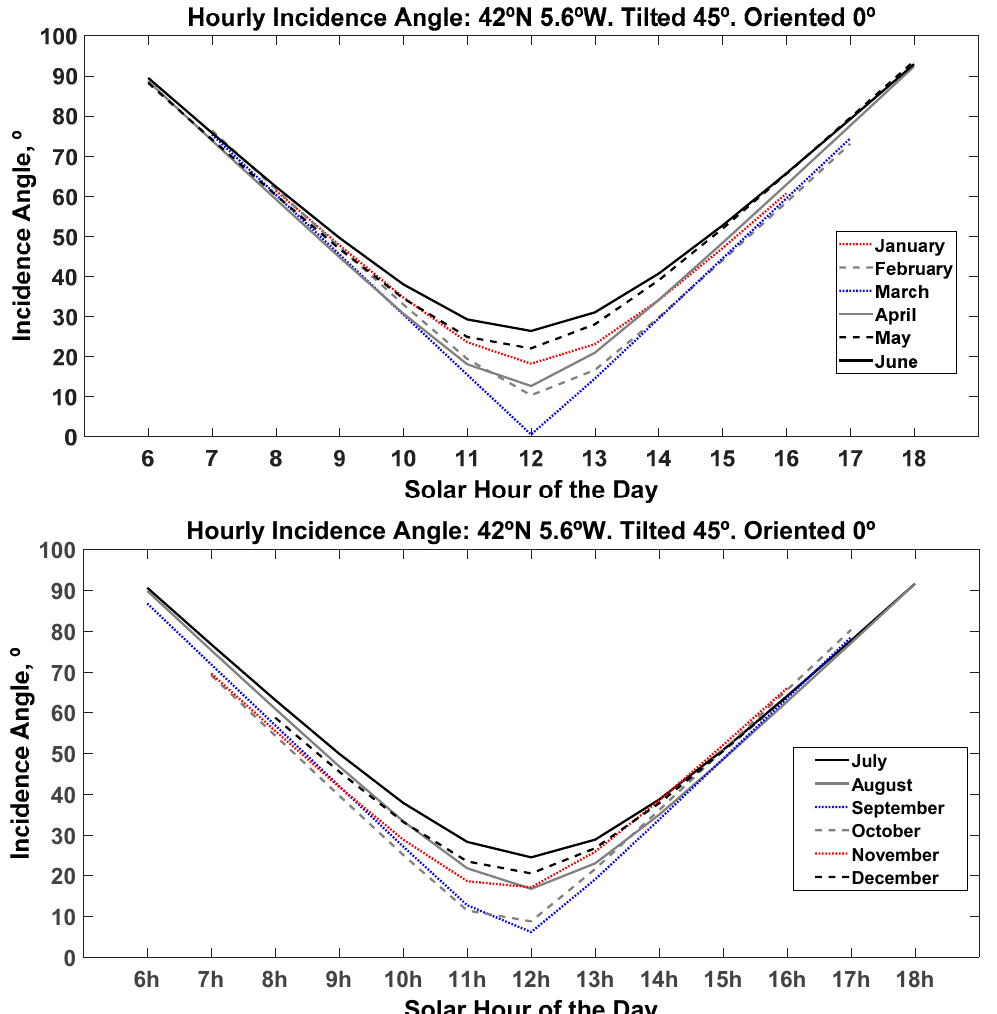
Figure 7. Hourly incidence angle calculated at latitude 42° N and longitude 5.6° W for the 15th day of each month. ( Top ) January to June; ( bottom ) July to December. The minimum values of the angle of incidence, which were obtained at solar noon for each day of the year, are presented in Figure 8. Incidence Angle at Solar Noon: 42ºN 5.6ºW. Tilted 45º. Oriented 0º Figure 8. Incidence angle at solar noon calculated at latitude 42° N and longitude 5.6° W for all days of the year. 3.5. Results for Hourly Global Irradiance and Hourly Mean Solar Irradiance on the Solar Panel The data recorded for the global solar irradiation on the horizontal surface during 2011 in the agrometeorological station located in the town of Mansilla Mayor (León, Cas- tile and León region, Spain), as part of the SIAR network, were used to apply the method- ology developed in Simulink-MATLAB for the estimation of the global solar irradiation value on a surface with an inclination of 45° and oriented towards the equator. The results of the different methods of obtaining diffuse solar irradiation are shown below. Figure 9 shows the values of the daily global solar irradiation obtained from the hor- izontal SIAR network, together with the calculations carried out for the estimation of the daily global solar irradiation on a surface inclined at 45° and oriented to the equator using the following four models. −